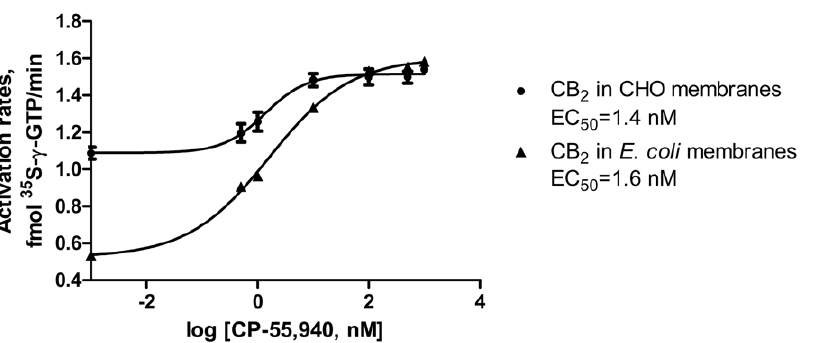
Figure 3. Activation of G proteins by recombinant CB 2 in E.coli membranes expressing CB 2 -130 and in CHO membranes expressing CB 2 . 4 ng of CB 2 was used in the assay and the figure depicts data 6 S.D. (error bars) of duplicate determinations from representative experiments